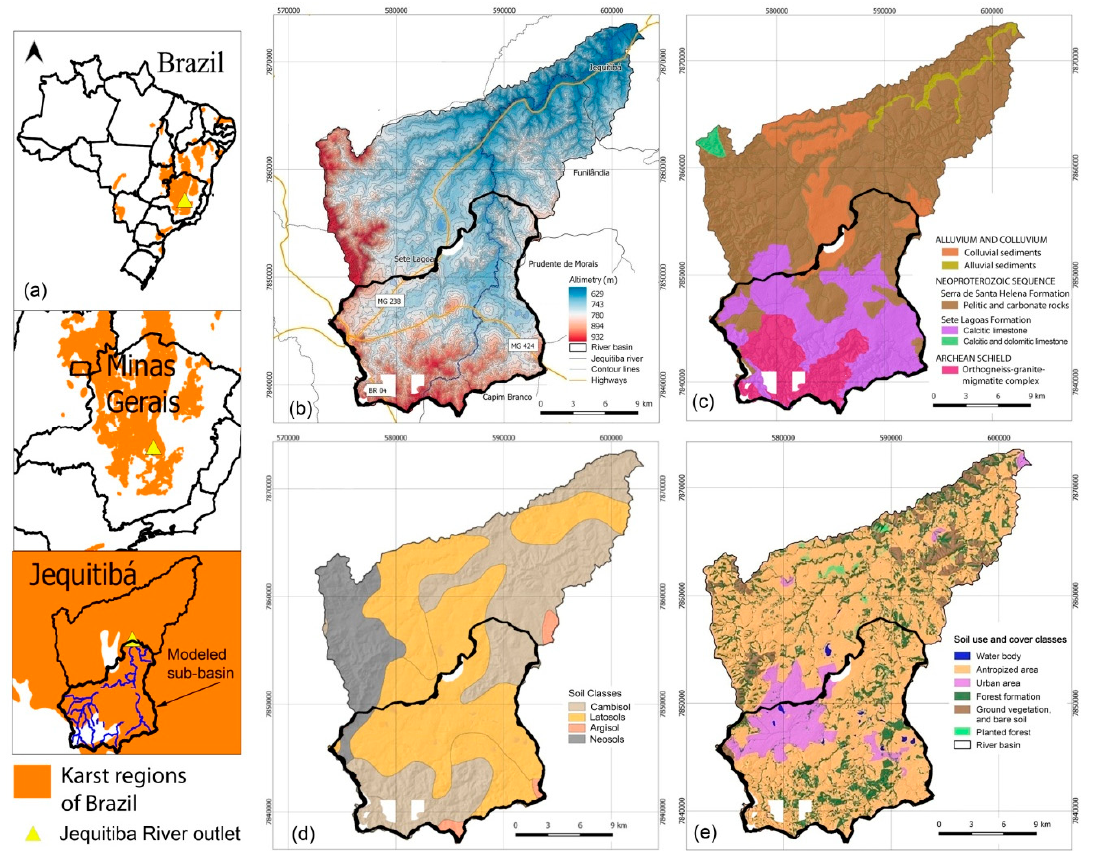
Figure 1. ( a ) Location of study area: Jequitiba River basin, Minas Gerais, Brazil; ( b ) topographic map of Jequitiba River basin, with indication of towns, drainage network, and main road network; ( c ) lithologic map of the Jequitiba River basin; ( d ) soil map of the Jequitiba River basin; ( e ) land use and cover map of the Jequitiba River basin; The geographic reference for the maps is the UTM projection system, SIRGAS 2000 datum, 23 south time zone.